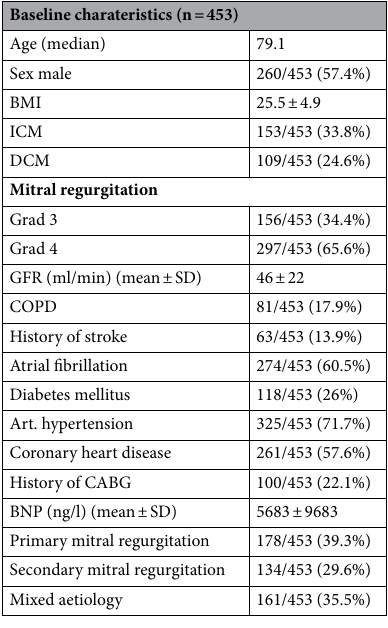
Table 1. Baseline characteristics of the MitraClip cohort.